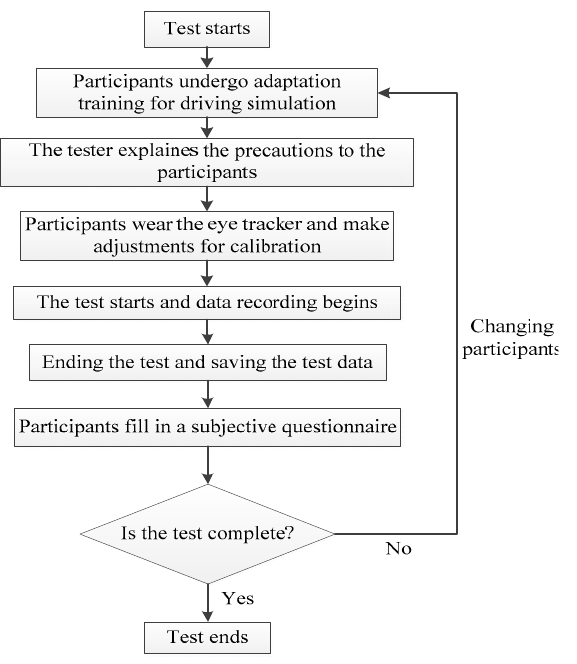
Figure 3. The process of simulated driving tests.